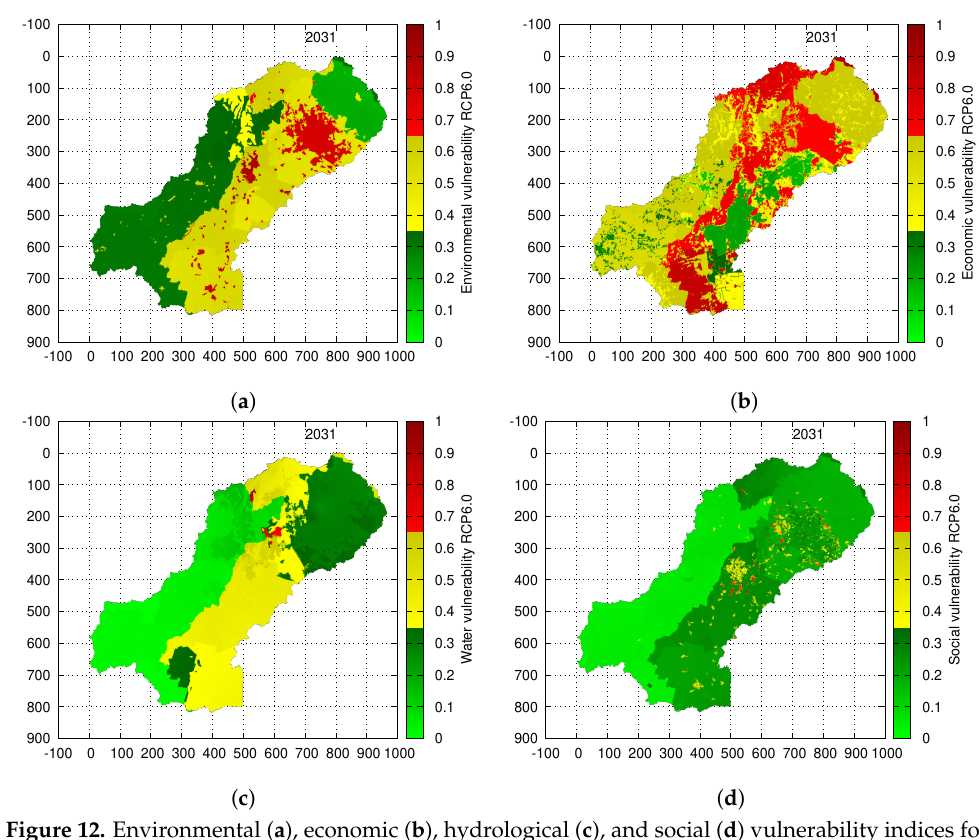
Figure 12. Environmental ( a ), economic ( b ), hydrological ( c ), and social ( d ) vulnerability indices for the year 2031